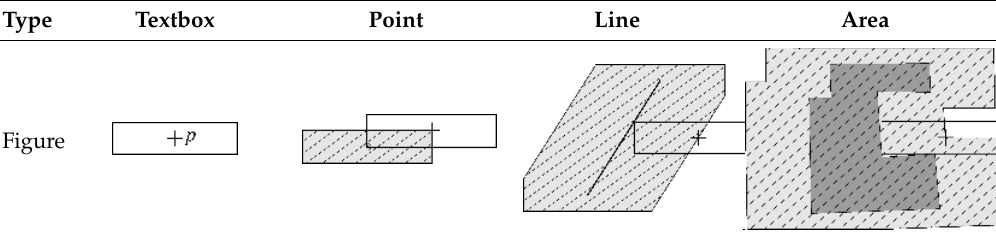
Figure 6. The flow diagram of the candidate label region generation. ( a ) Point feature, label textbox, and search space; ( b ) a label placement case; ( c ) the generated region of immovability; ( d ) the conflict- free labeling space.